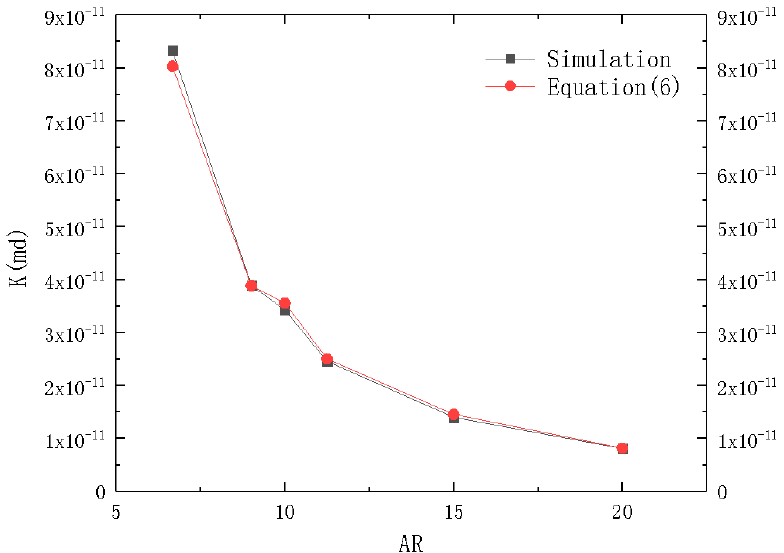
Figure 3. Comparison of permeability Equation (6) (black squares) and simulation results (red